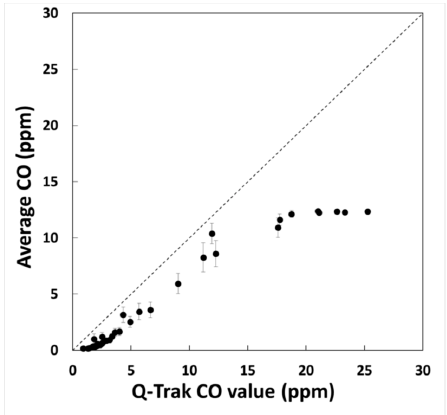
Figure 6. Decay test results of the average CO concentration for all sensors relative to the Q-Trak Plus 8552 reference measurements. The y-axis error bars represent one standard deviation.